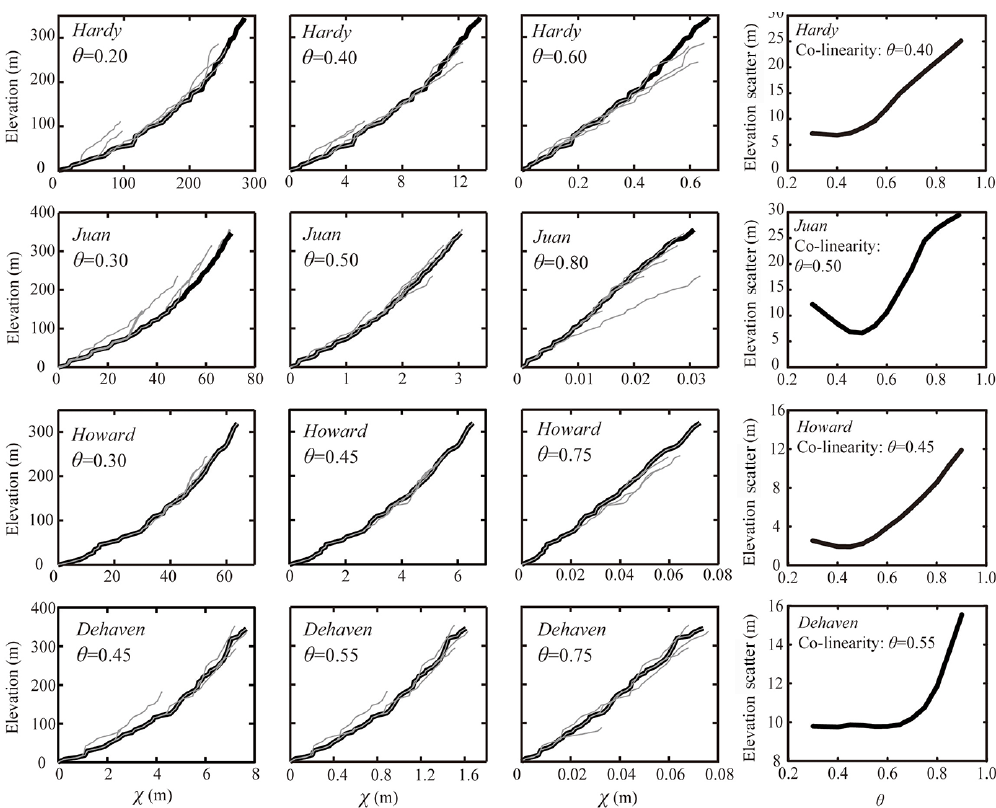
Figure 14. Concavity values that maximize the co-linearity of the main stem with its tributaries. Black thick lines in the χ − z plots are